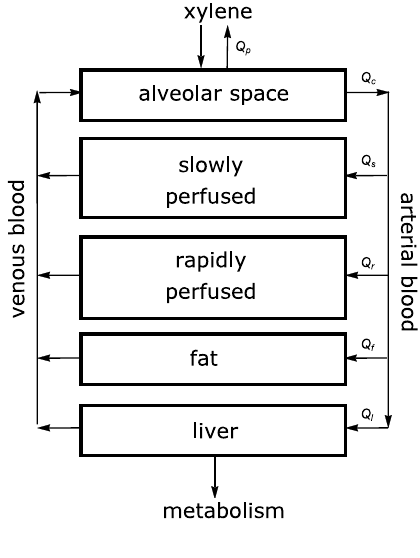
Fig. 1. The structure of the PBPK model of xylene from Tardif et al. [39] used in